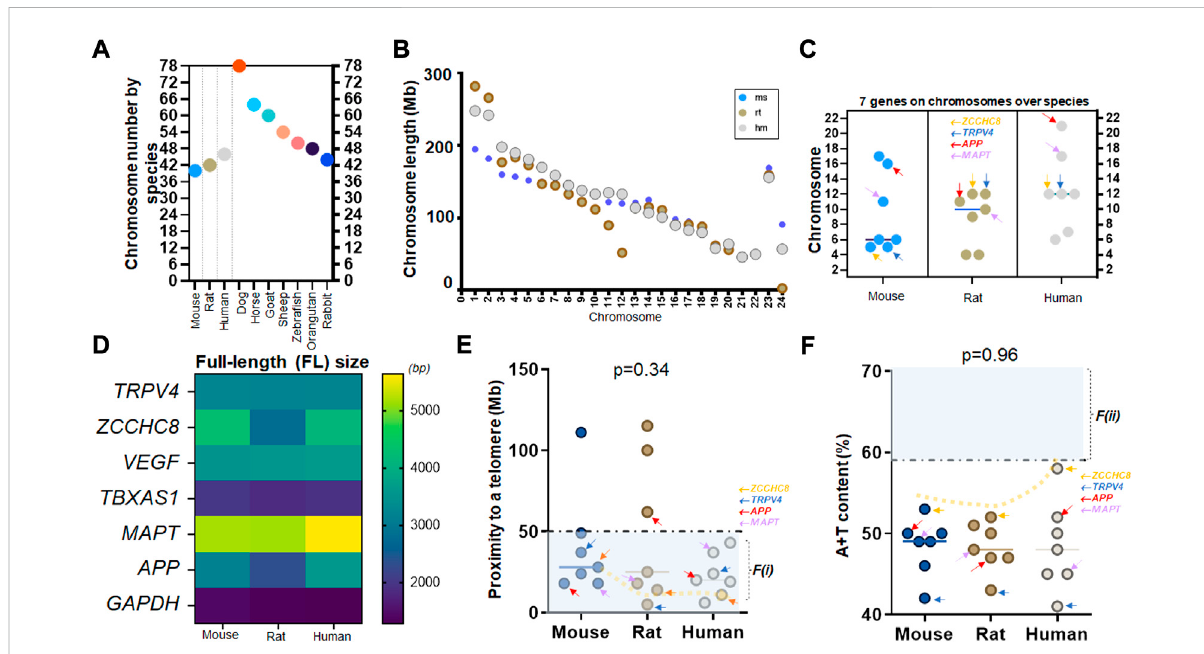
FIGURE 3 A consistent mutability of TRPV4 over mouse, rat, and human genomes (A) Chromosome numbers offrequently used laboratory animals (mice andrats)andhumansascomparedtootherspeciessuchasdogstorabbits.Notethatorangutan(48)andrabbit(44)havesimilarnumberstohumans at46chromosomes (23pairs) while dogsare much higherat78. (B) Scatter plotsshowingchromosome length ofthreespecies withrespectto each chromosome(chr)ofchr1toXorY;mice(ms),rats(rt),andhumans(hm).Notethatlargeranimalsdonotalwaysshowlongerchromosomes.In chr1,rats, which aresmallerinbody size,have longer nucleotide sizesthan humans. x -axis ispair-wise;humansshowing23pairs fromchr1 tochrX orY(Morton,1991) (C) Locationsofsevengenesinvestigatedinthisstudyoverthreespeciesofmouse,rat,andhuman.NotethatAPPandMAPThave evolved into shorter chromosomes (chr17-22) in humans as compared to rodents (D) The full-length (FL) size of seven genes over three species. Note that TRPV4, VEGF, and TBXAS1 show consistent molecular sizes over three species while ZCCHC8, APP, and MAPT differ in humans as compared to rodents. (E) Proximity to telomeres of seven genes over three species. Note that seven human genes investigated in this study have evolved in a way meeting proximity to telomeres or the fi rst factor, F(i), associated with high mutation rate as all seven human genes are at less than 50 Mb as compared to those of mice and rats. (F) A+T content of seven genes over three species. Seven human genes demonstrate a similar characteristic of dif fi culty in meeting this second factor, F(ii), associated with high mutation rate while ZCCHC8 gene has evolved towards 59%. A dottedtrendlinefollowsZCCHC8 geneinmice,rats,andhumans (E,F) .Arrowsinorange,blue,red,andpurpleindicating ZCCHC8,TRPV4, APP,and MAPT, respectively (C,E,F)